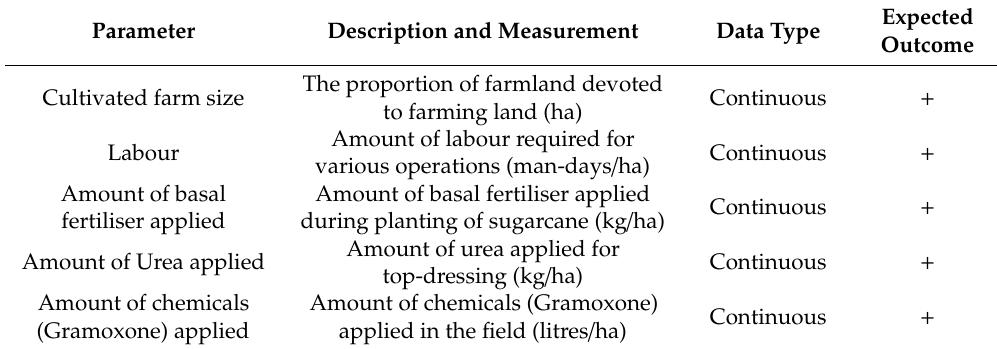
Table 1. Explanatory variables used in the regression analysis and their expected outcomes. Parameter Description and Measurement Data Type The proportion of farmland devoted + Cultivated farm size to farming land (ha) Amount of labour required for Continuous + Labour various operations (man-days / ha) Amount of basal fertiliser applied during planting of sugarcane (kg /